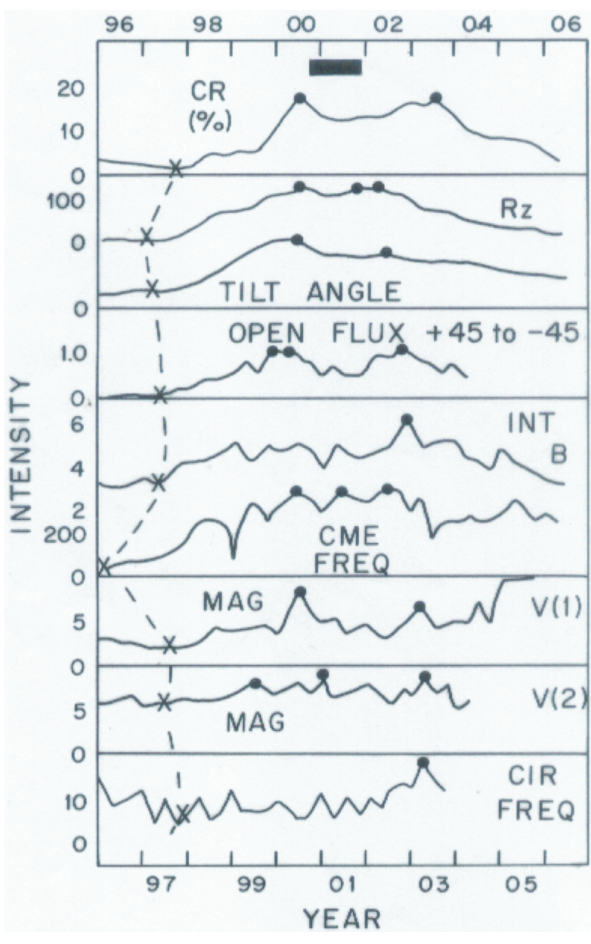
Fig. 8. Plots of 3-monthly values for cycle 23 (1996–2006, ordinate in percent for CR, intensity units arbitrary for others). Maxima are marked with big full dots. Minima during 1996–1997 are marked with crosses. The full rectangle at the top shows the reversal of solar polar magnetic